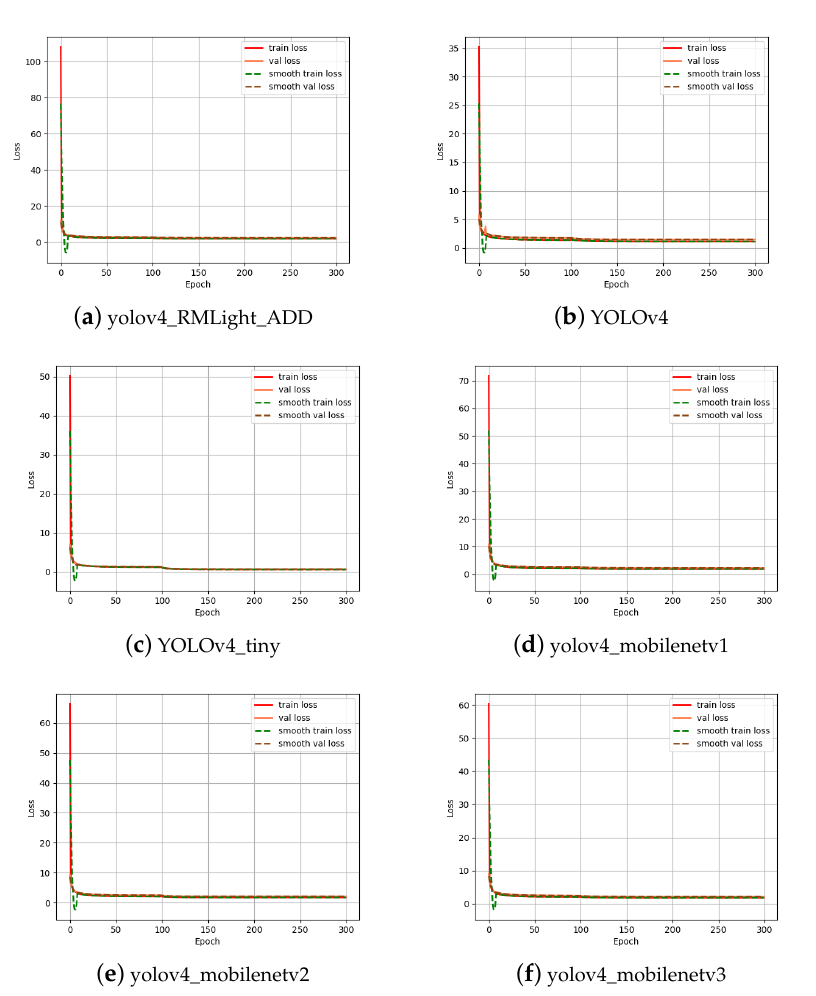
Figure 12. The convergence curve of the loss function for different models. ( a ) Represents the loss function plot for the training of our proposed network model. ( b ) Represents the loss function plot for the training of the YOLOv4 network model. ( c ) Represents the loss function plot for the train- ing of the YOLOv4_tiny network model. ( d ) Represents the loss function plot for the training of the yolov4_mobilenetv1 network model. The yolov4_mobilenetv1 means replacing YOLOv4’s backbone feature extraction network with MobileNetv1. ( e ) Represents the loss function plot for the training of the yolov4_mobilenetv2 network model. The yolov4_mobilenetv2 means re- placing YOLOv4’s backbone feature extraction network with MobileNetv2. ( f ) Represents the loss function plot for the training of the yolov4_mobilenetv3 network model. The yolov4_mobilenetv3 means replacing YOLOv4’s backbone feature extraction network with